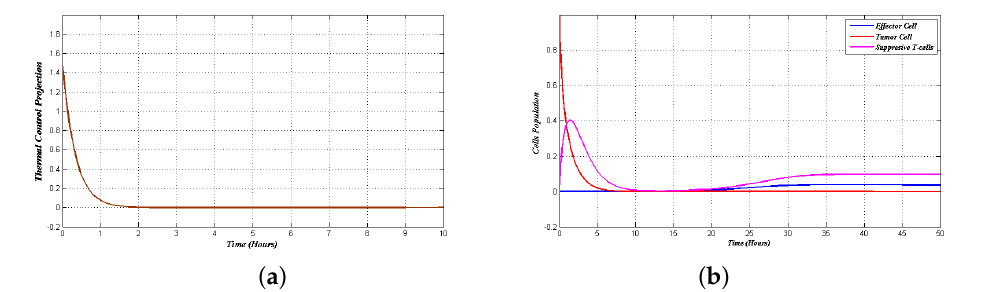
Figure 3. Numerical result For thermal optimal control when Φ = ¯ H in System (1). ( a ) Thermal control projection ( b ) Cell dynamics.